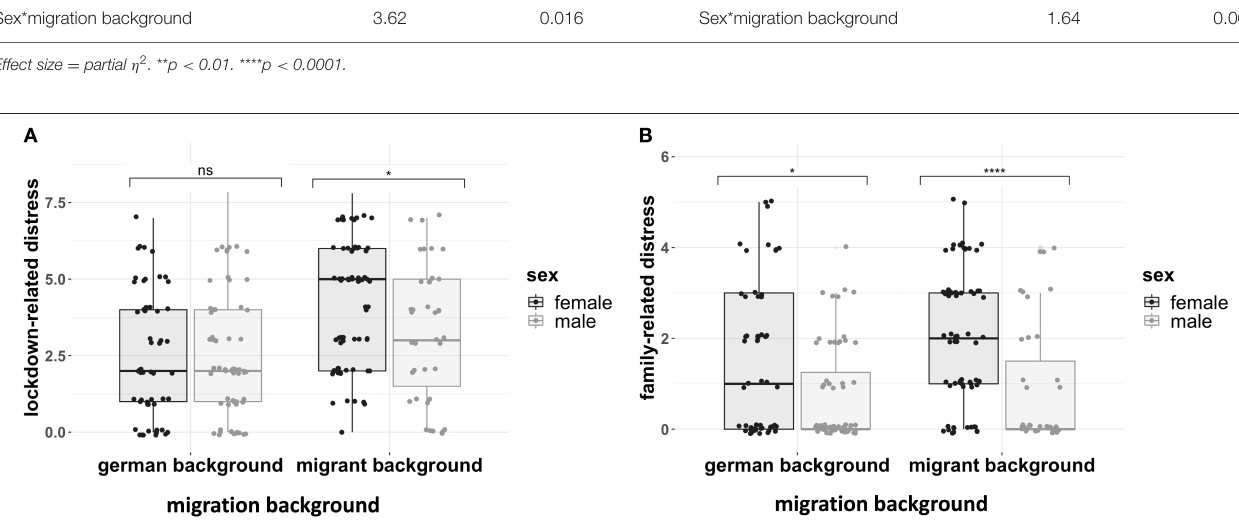
FIGURE 1 | (A) Lockdown-related distress across sex and migration background. (B) Family related distress across sex and migration background. Both boxplots show interquartile range, with the middle bar being the median value. N = 221. Significance bars refer to follow-up Bonferroni-adjusted contrasts (**** p < 0.00001, * p < 0.05, ns = non-significant).